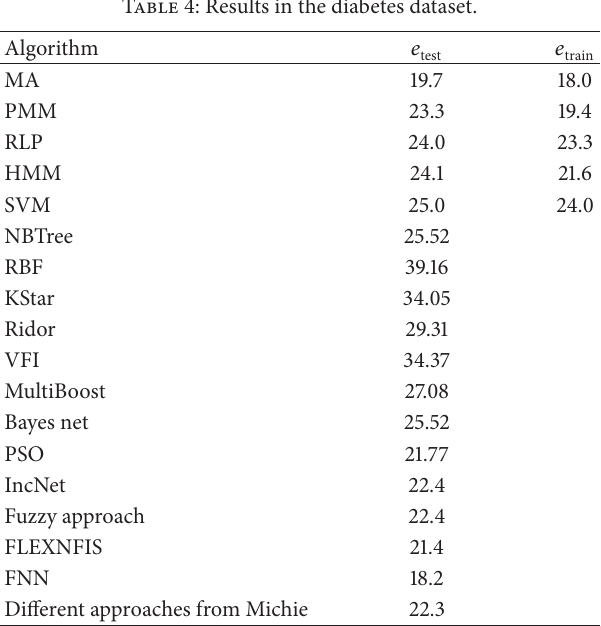
Table 4: Results in the diabetes dataset.